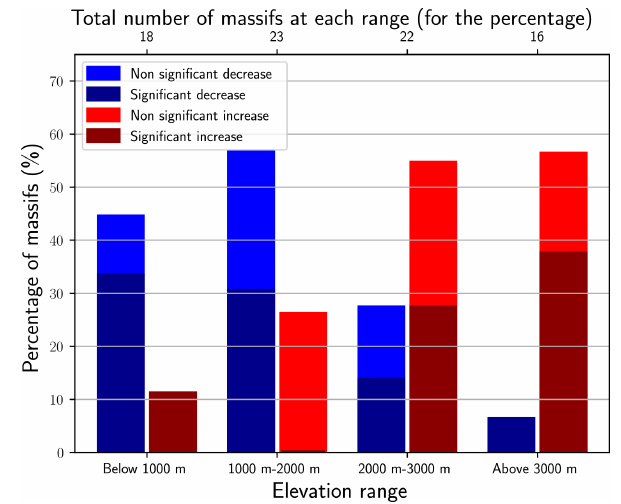
Figure 6. Percentages of massifs with significant/non-significant trends in 100-year return levels of daily snowfall for each range of elevation. A massif has an increasing/decreasing trend if the 100- year return level of the selected elevational–temporal model has in-